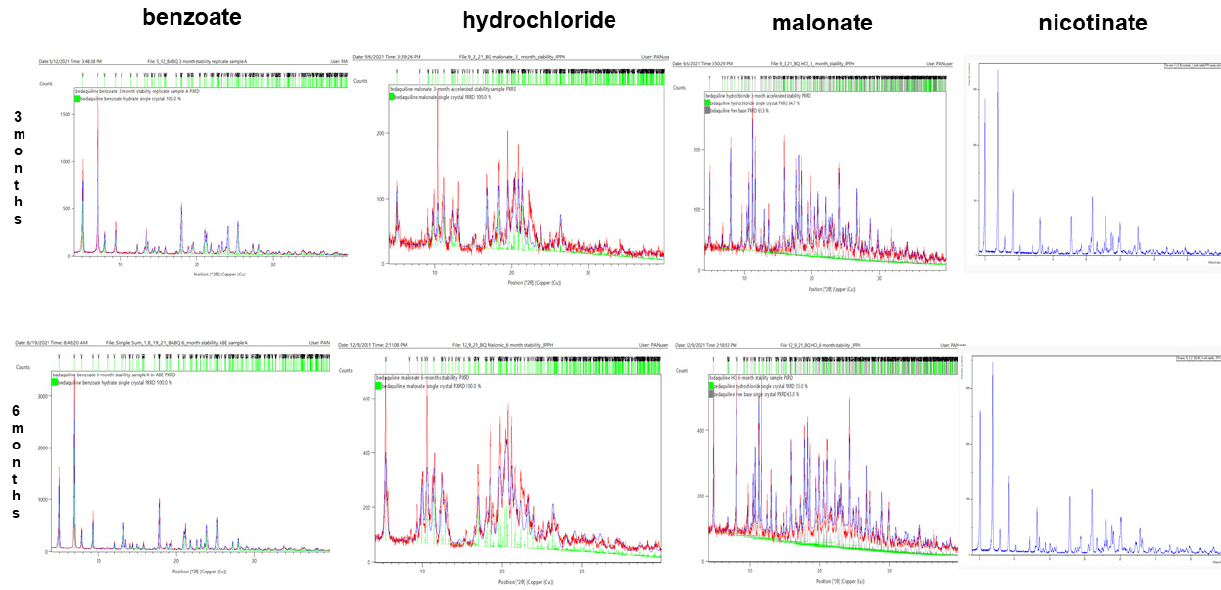
Figure 11. Rietveld refinement of PXRD for 3 and 6- months accelerated stability samples of be- daquiline salts. Over 3 months, benzoate, malonate, and nicotinate salt samples maintained their crystal structures but the hydrochloride salt sample lost its crystallinity. Over 6 months, benzoate, malonate, and nicotinate salt samples retained their crystalline structures but the hydrochloride salt sample lost its